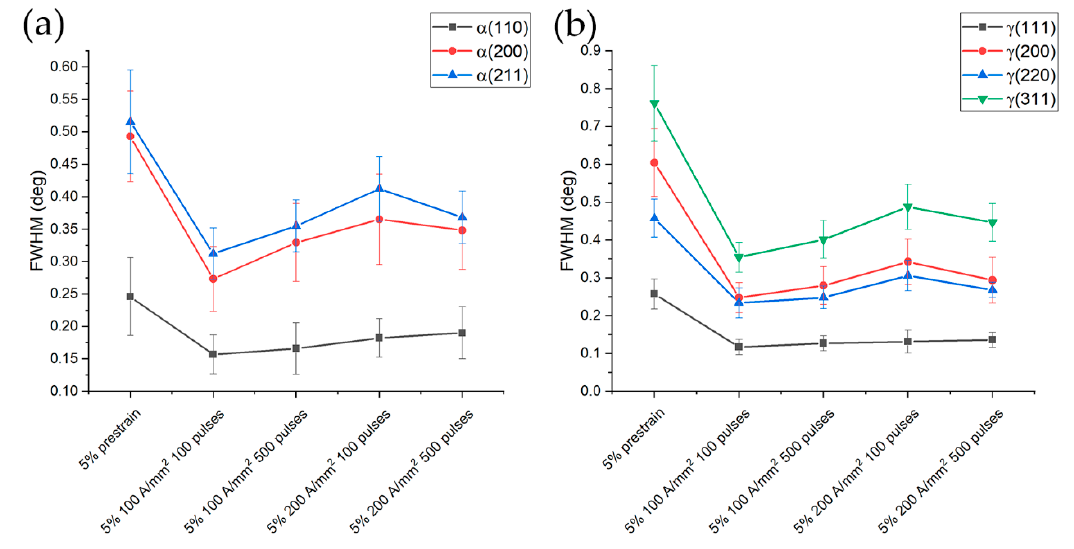
Figure 19. FWHM evolution of ferrite ( a ) and austenite ( b ) for the specimens prestrained at 5% and electropulsed.